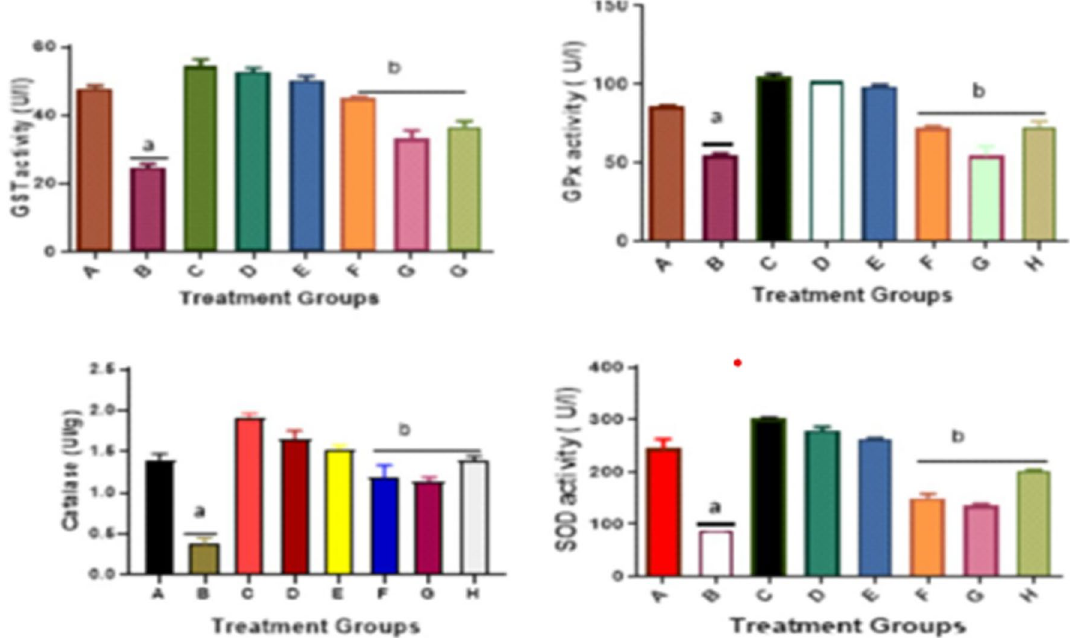
Fig. 1 Activities of different cellular antioxidant defense (GST, GPx, Catalase, and Superoxide dismutase) in the brain tissue of male Wistar rats in different experimental groups. Values are mean b significantly different compared with the positive control group B treated with KBrO3 only (p < 0.05). Group A received distilled water, B: = 30 mg/kg KBrO3, C: 50 mg/kg Quercetin, D: 300 mg/kg AEAC, E: 150 mg/kg AEAC, F: